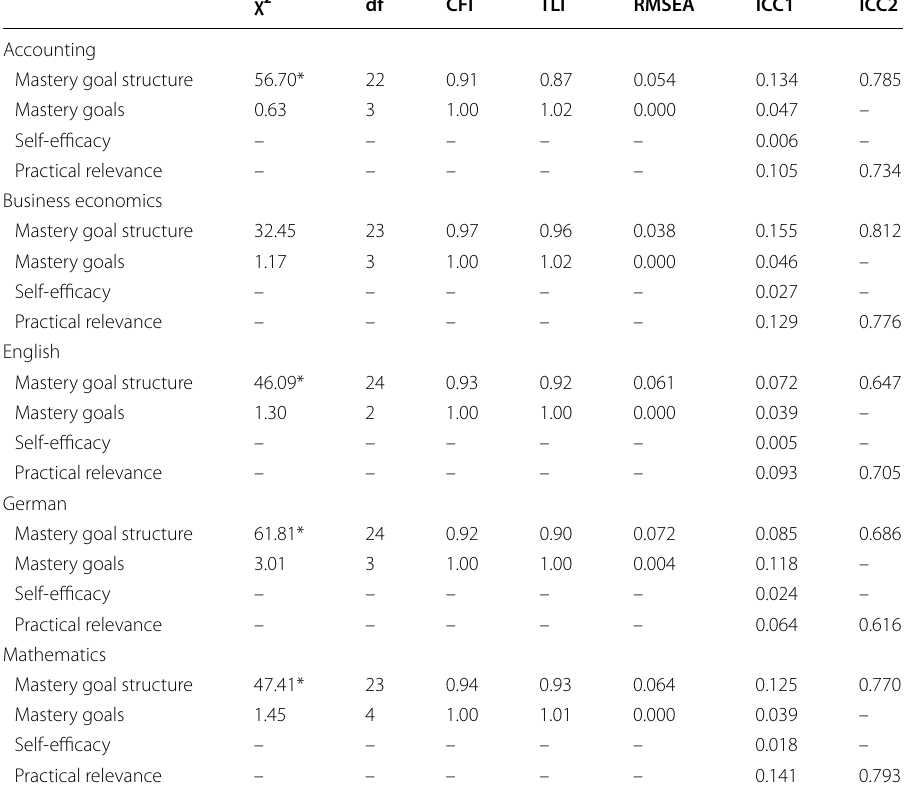
Table 1 Multilevel confirmatory factor analysis result: model fit, ICC1 and ICC2 for all scales of mastery goal structures, mastery goals, self‑efficacy, and practical relevance in five subjects